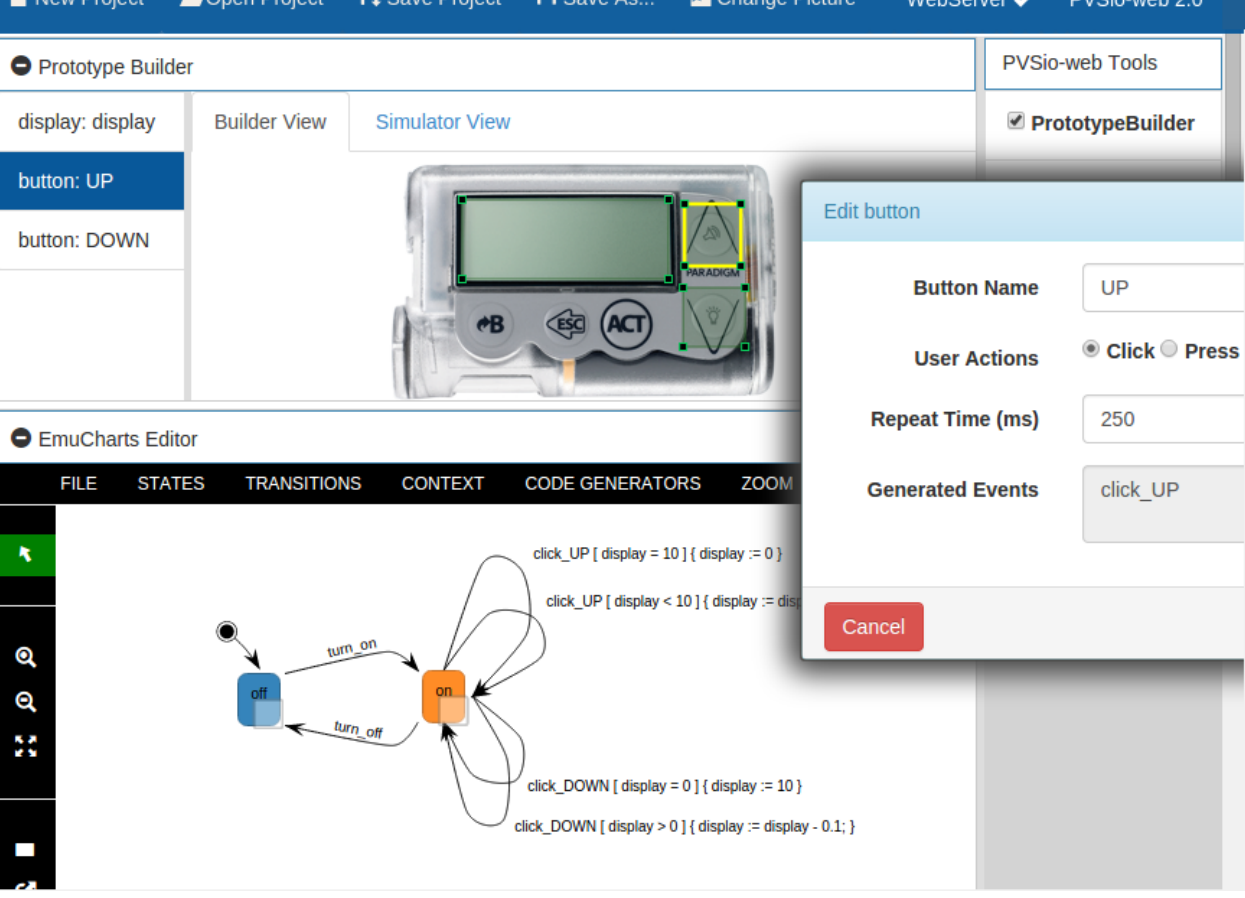
Figure 1: Screenshot of the PVSio-web prototyping